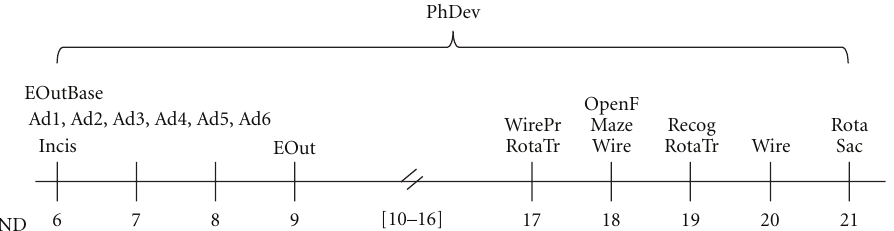
Figure 1: Study tests and procedures timeframe. PhDev: growth and physical development assessment (PND 6–21); EoutBase: baseline testing (righting reflex, negative geotaxis, and locomotor activity) (PND 6); EOut: early outcome assessment (PND 9); Adm: administration procedure, according to group (administration of fentanyl, administration of 0.9% saline solution, or manipulation) (PND 6–8); Incis: incision or manipulation, according to group (PND 6); WirePr: wire hanging maneuver pretest (PND 17); Wire: wire hanging maneuver test (PND 18 + 20); RotaTr: accelerating rotarod training (pretest) (PND 17 + 19); Rota: accelerating rotarod test (PND 21); OpenF: behavior in open-field arena (PND 18); Maze: elevated plus maze test (PND 18); Recog: novel object recognition test of short-term memory (PND 19); Sac: sacrifice (PND